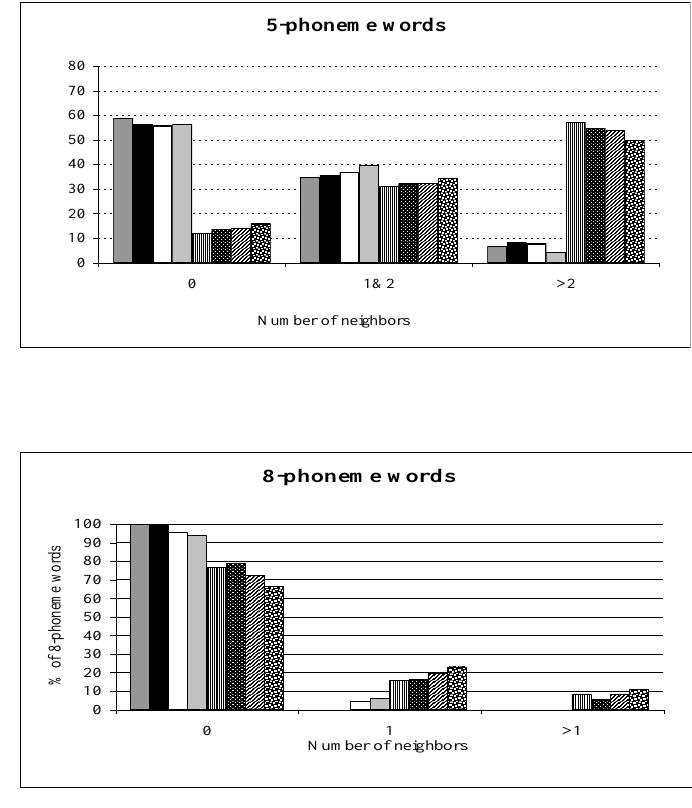
Figure 2. Neighborhood density for words with 3-, 4-, 5-, and 8-phonemes in the Viana (3-, 4-, and 5-year-old) and Ramos-Pereira (R-P; 1-2 year old) lexicons. We also present neighborhood density analyzed with reference to the adult Porlex